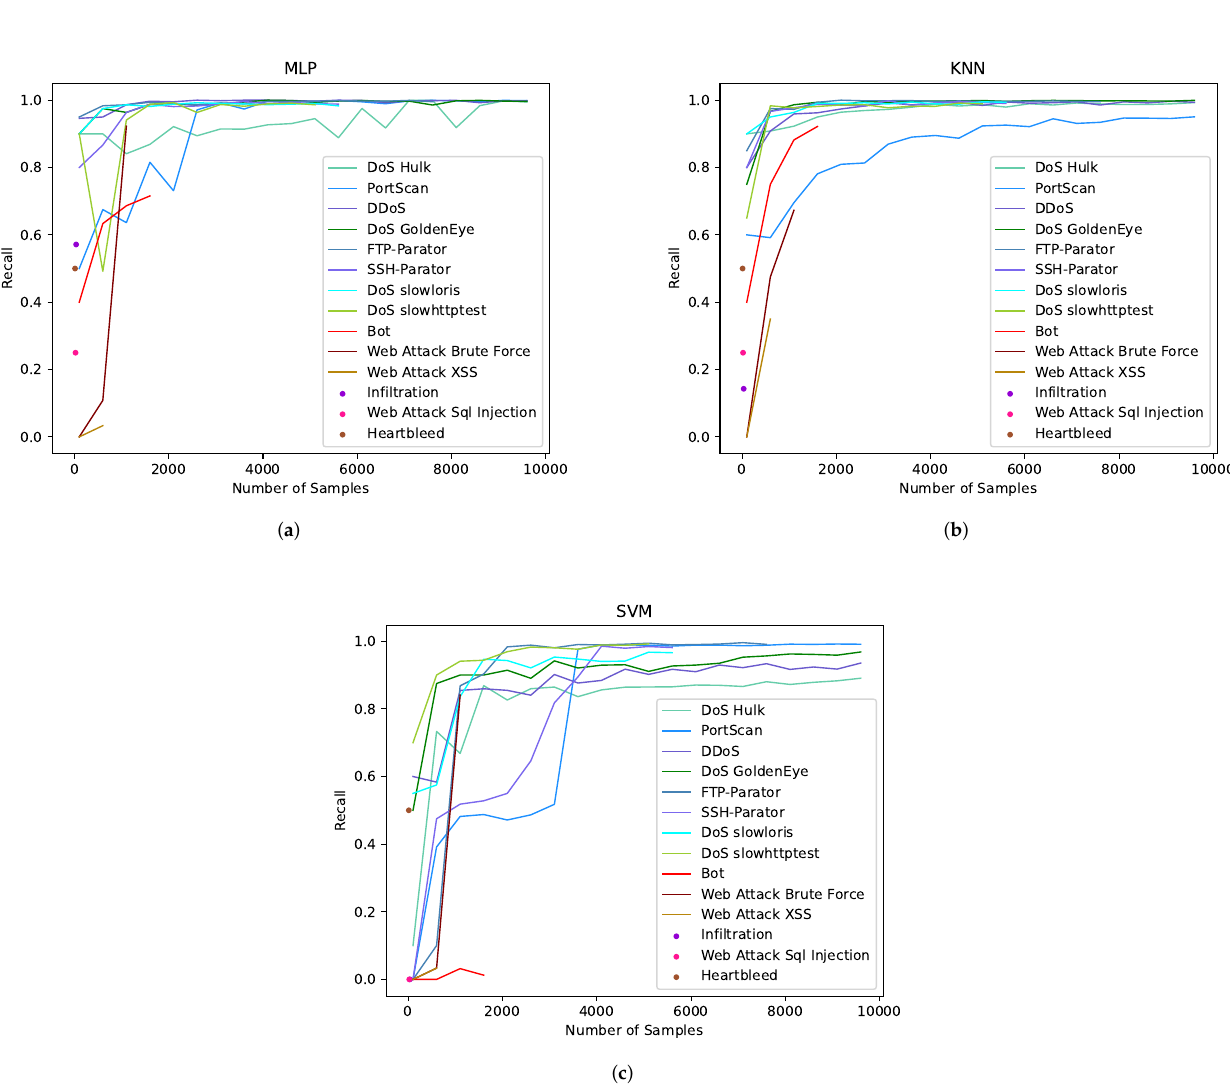
Figure 4. Growth curve of Recall indicator with number of traffic samples using three machine learning algorithms. ( a ) MLP; ( b ) KNN; ( c )